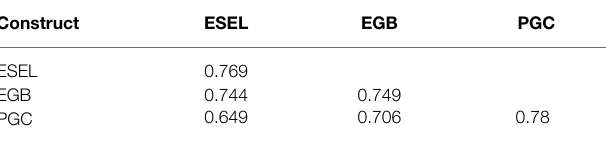
TABLE 4 | Fornell Larcker